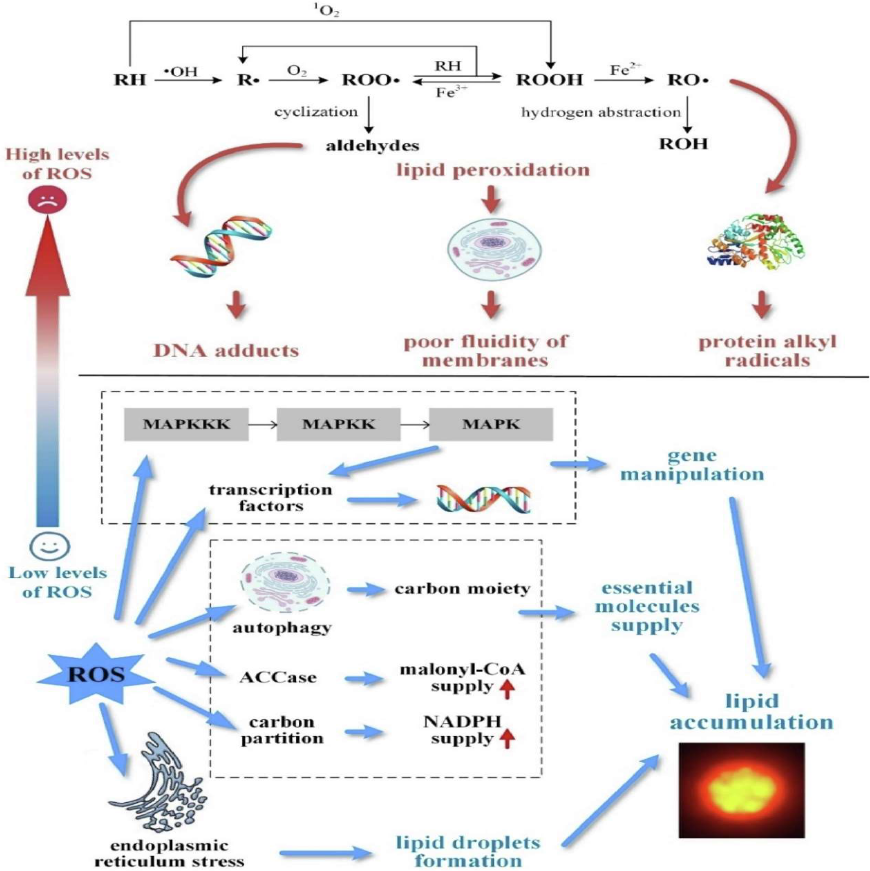
Figure 2. Lipid peroxidation and accumulation mediated by ROS. R: hydrocarbon chain & R · : lipid alkyl radical & RH: the fatty acid in lipid & ROOH: hydroperoxy fatty acids & ROH: lipid hydroxide & ROO∙: lipid peroxyl radical & RO: lipid alkoxyl radical & MAPK: mitogen-activated protein kinase & MAPKK: MAPK kinase & ACCase: Acetyl-CoA carboxylase & MAPKKK: MAPKK kinase. Reproduced from the permission of ref. [108].